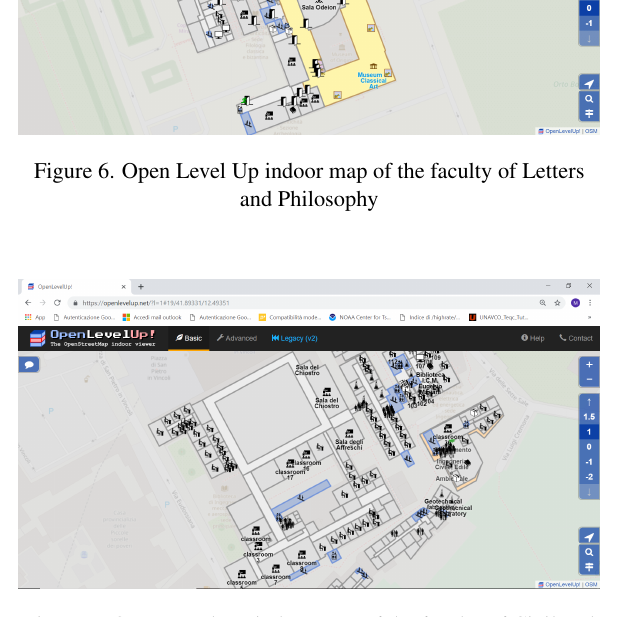
Figure 7. Open Level Up indoor map of the faculty of Civil and Industrial Engineering